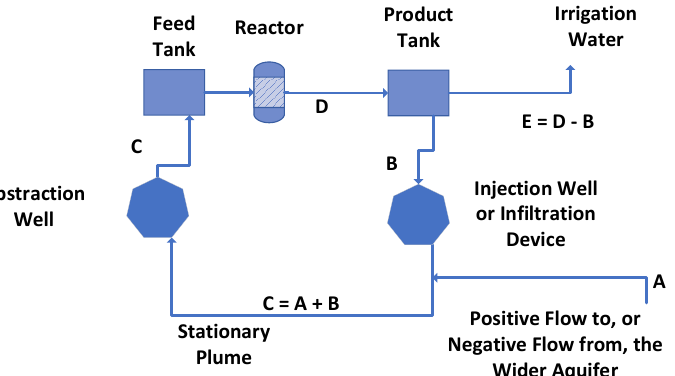
Figure A6. A conceptual mass balance model associated with creating a stationary desalinated groundwater plume within an aquifer. A, B, C, D, and E are fluid flow rates m 3 m −2 unit time −1 .